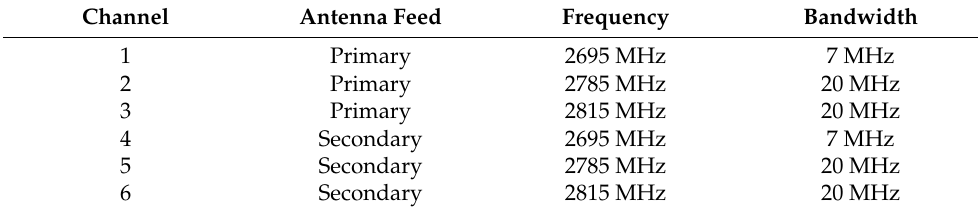
Table 6. Data collection channels for RMCSat.